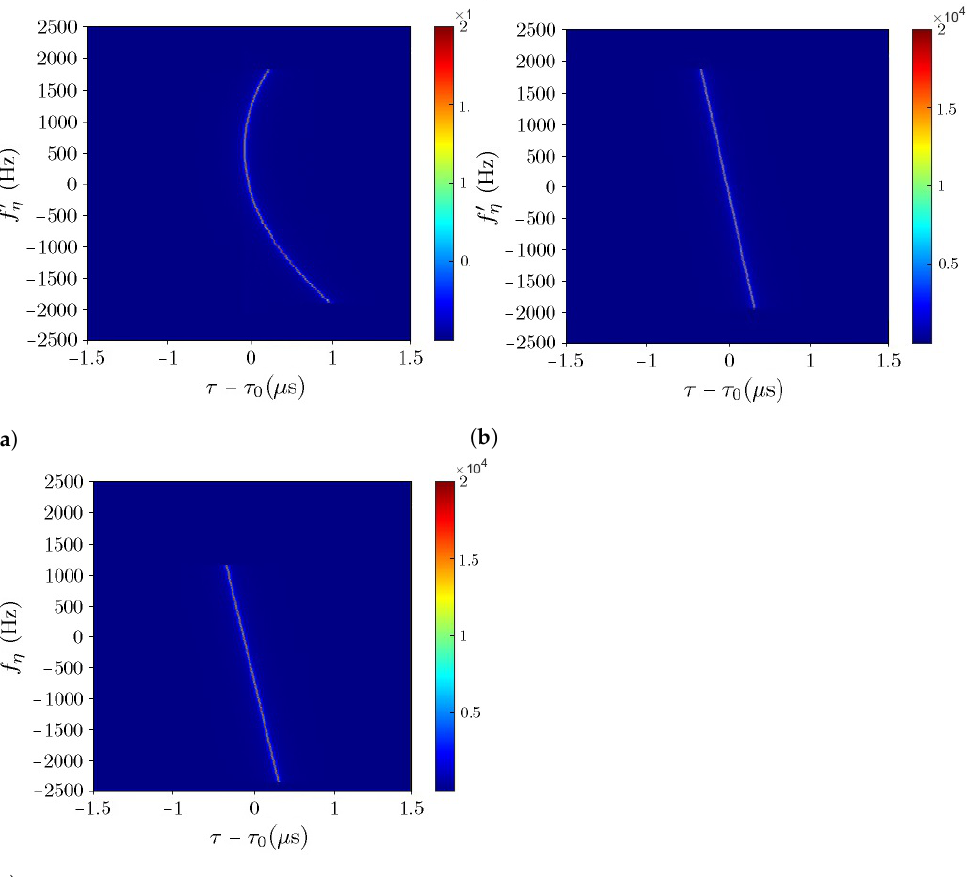
( τ , f (cid:48) ) , unwrapped Doppler spectrum after solving ASA issue, η 9